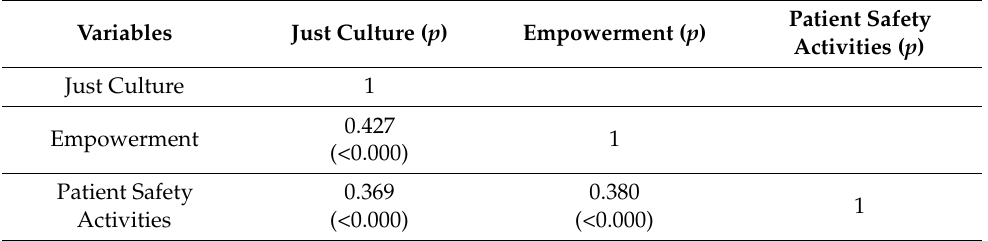
Table 3. Correlations among Nurses’ Perceived Just Culture, Empowerment, and Patient Safety Activities.